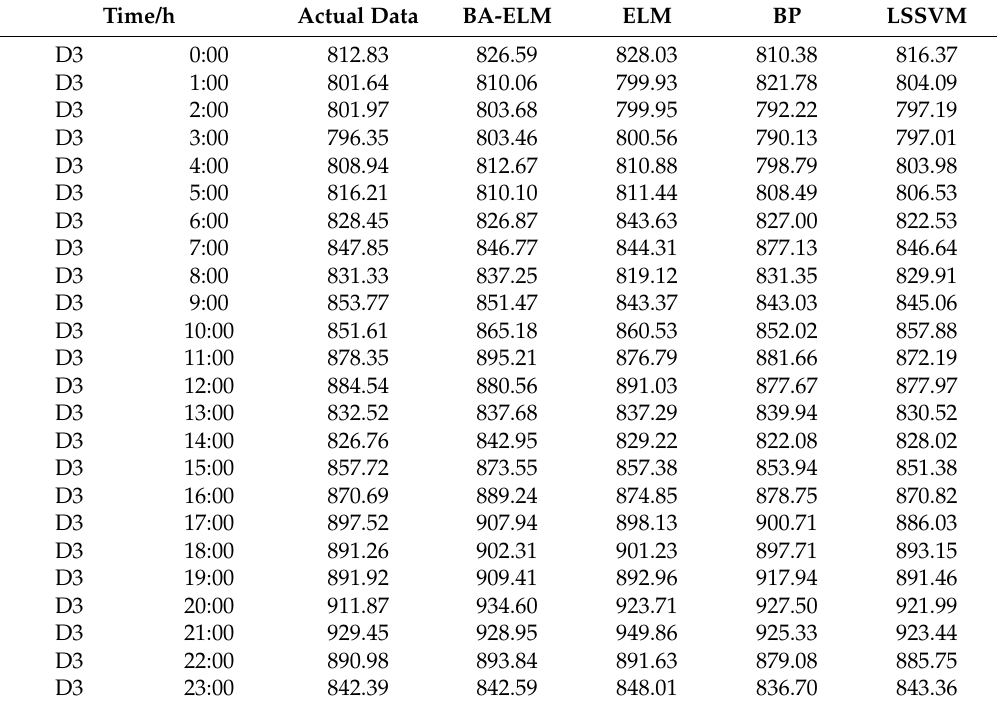
Table 9. Actual load and forecasting results on Day 3 (Unit: